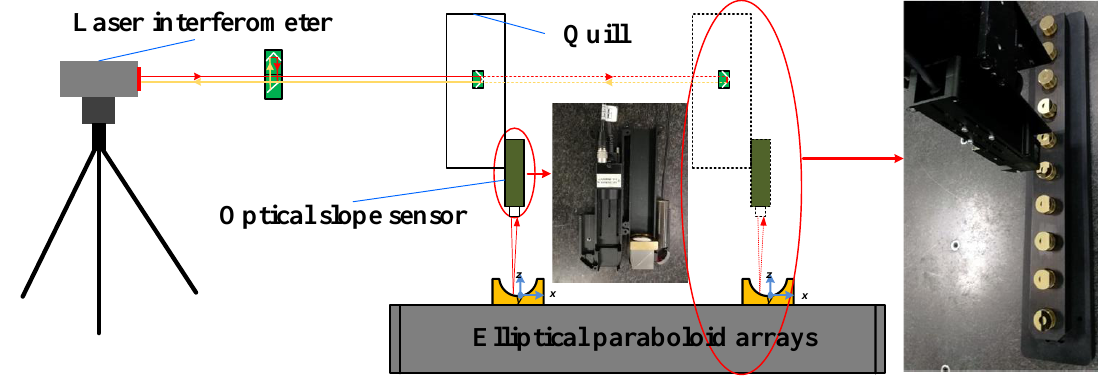
Figure 4 . Experimental apparatus of the calibration system.